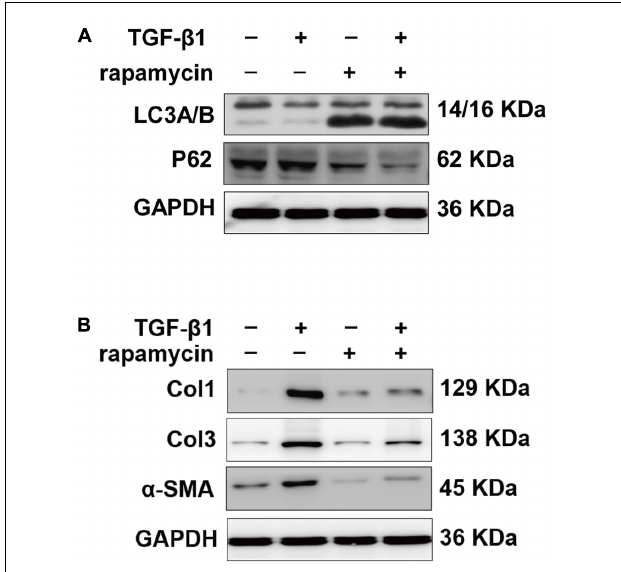
FIGURE 7 | Rapamycin regulates fibrotic gene expression in primary tenocytes. (A) Representative images of western blot of LC3A/B and p62 levels after TGF- β 1 (2 ng/ml) and/or rapamycin (500 nM) treatment for 24 h. (B) Representative images of western blot analysis of Col1, Col3, and α -SMA after different treatments. All experiments were performed three independent